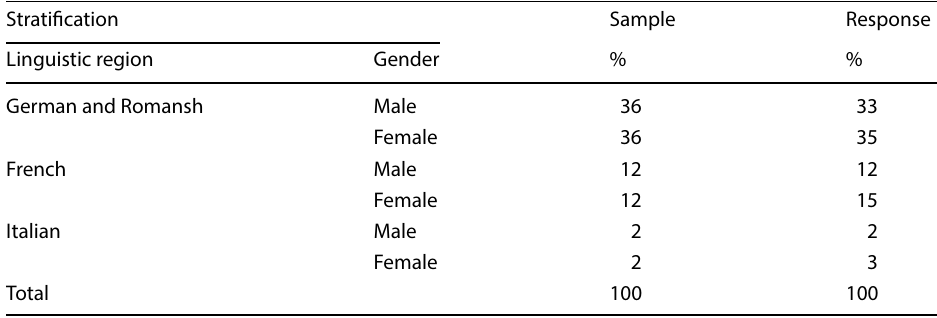
Comparison between drawn sample